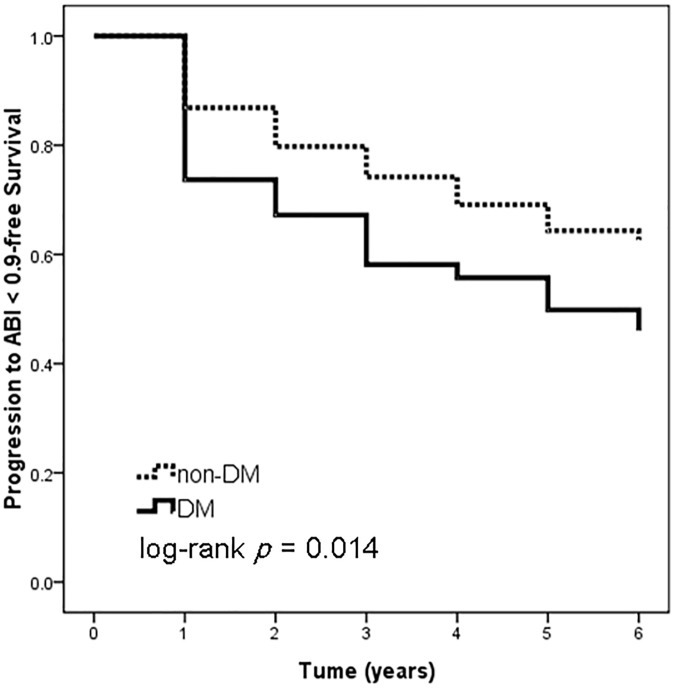
Kaplan-Meier analyses of progression to ABI < 0.9-free survival in patients with a baseline ABI ≥ 0.9.DM patients had worse progression to ABI < 0.9-free survival (log-rank test, p = 0.014) than non-DM patients.